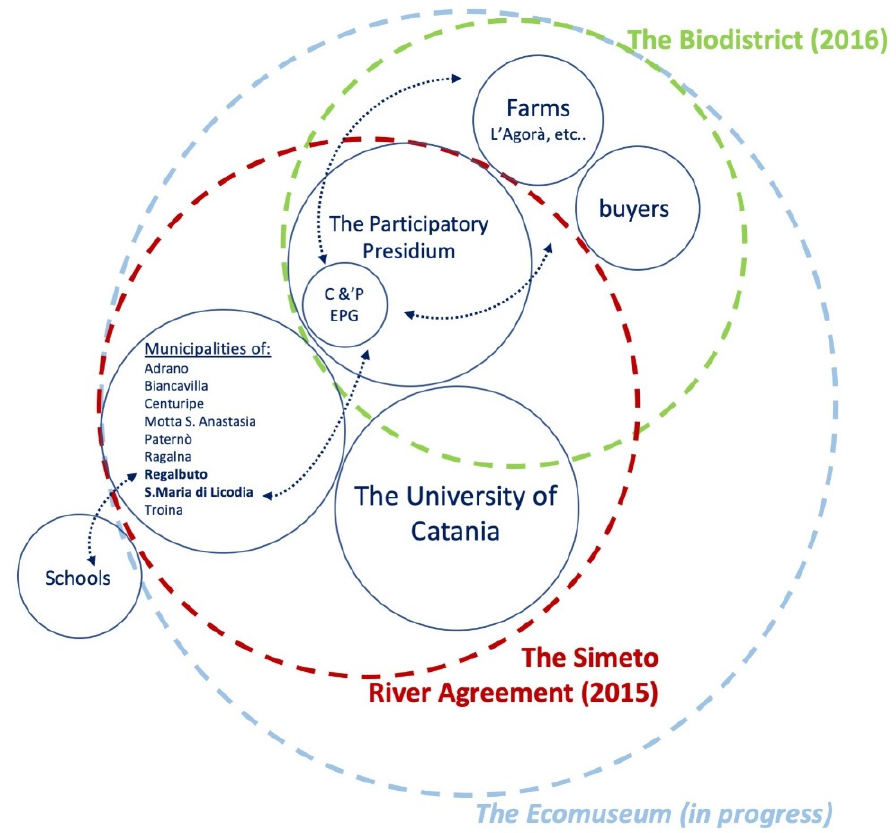
Figure 2. Parties involved in the food system component of the SRA biodistrict in relation with the evolving governance structures .